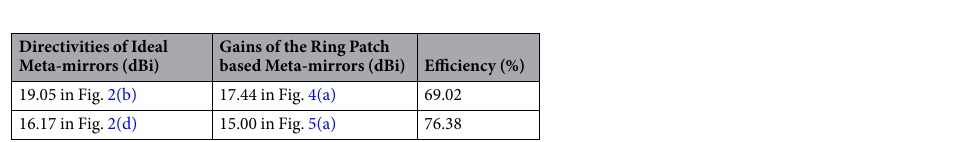
Figure 5. The radiation performances of the convex meta-mirror and conventional convex mirror. ( a ) The collimation of rays from the convex meta-mirror when excited by the WR62 waveguide at the focal point. ( b ) The focusing of rays from the convex meta-mirror when excited by a plane wave. ( c ) The divergence of rays from conventional convex mirror when excited by the WR62 waveguide. In ( a , b and c ), the real parts of E-fields are normalized by 550 V/m, 800 V/m, and 600 V/m respectively. ( d ) Far-field radiation patterns of the two cases in ( a and c ).